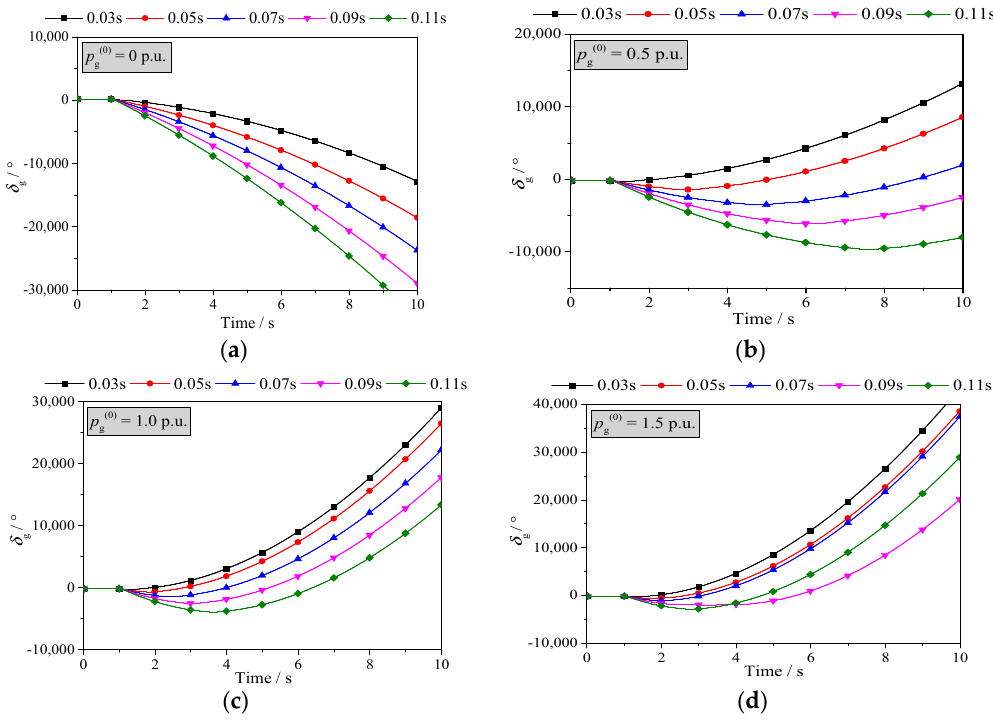
Figure 11. The swing curves of the sending-end generator power angle (classical model). ( a ) p g(0) = 0 p.u.; ( b ) p g(0) = 0.5 p.u.; ( c ) p g(0) = 1.0 p.u.; ( d ) p g(0) = 1.5 p.u.